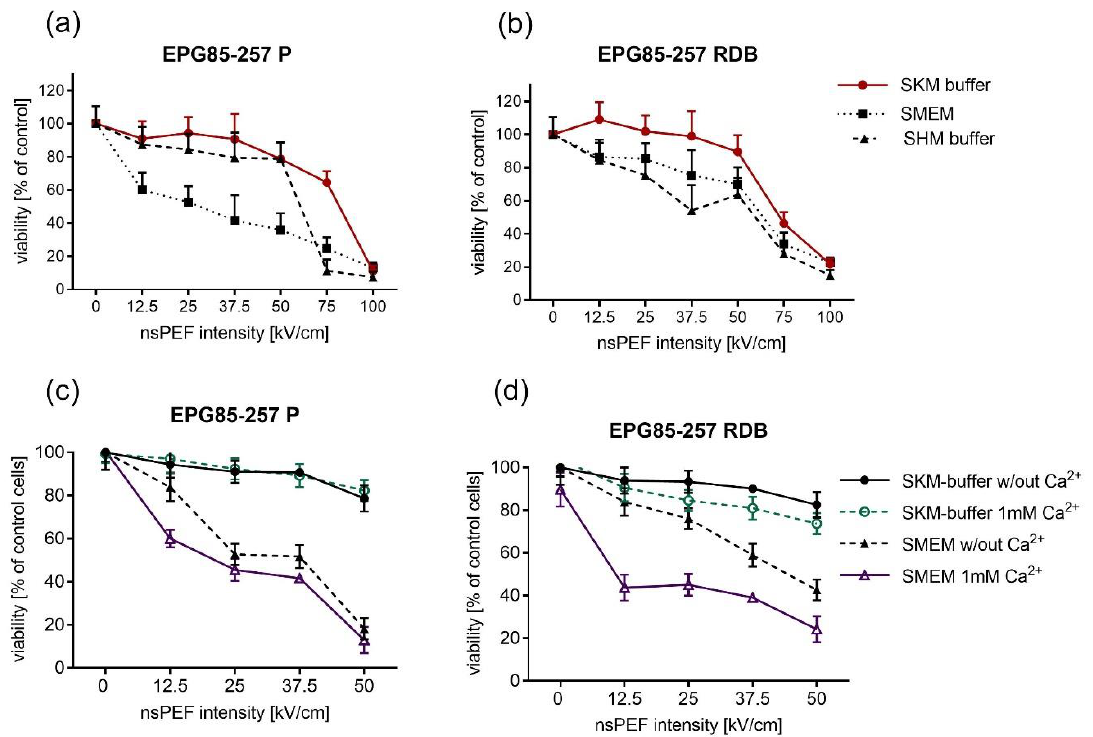
Figure 1. The evaluation of cell viability by MTT assay after 24 h post nsPEF in human gastric cells ( a ) sensitive, and ( b ) drug-resistant; with and without 1 mM calcium ions in ( c ) sensitive, and ( d ) drug-resistant cells. Data are mean ± SD (n = 3), * p < 0.05. SKM buffer — potassium-based buffer, SMEM — Spinner Modification of Minimum Essential Eagle ’ s Medium, SHM — 10 mM HEPES based buffer.